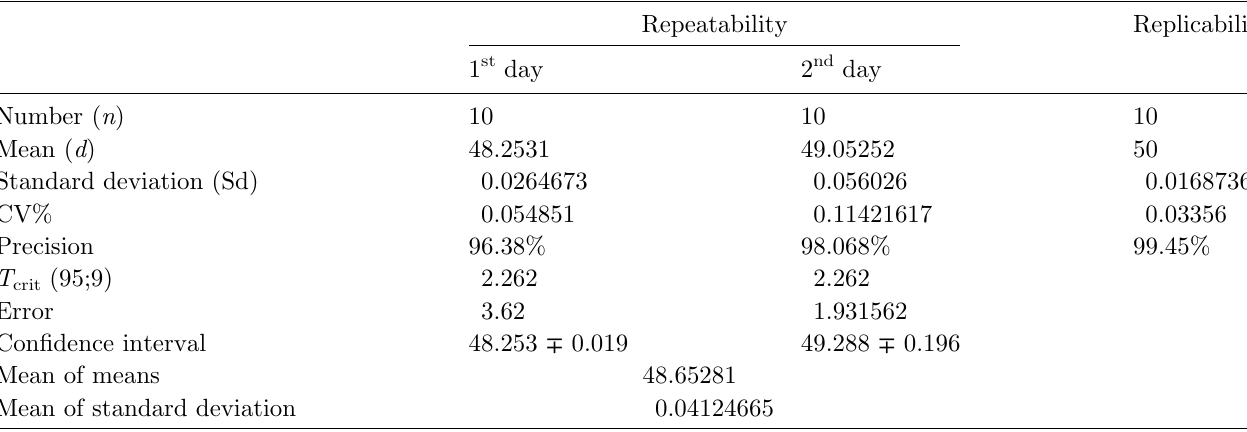
Table 6. Example of results obtained for a precision study